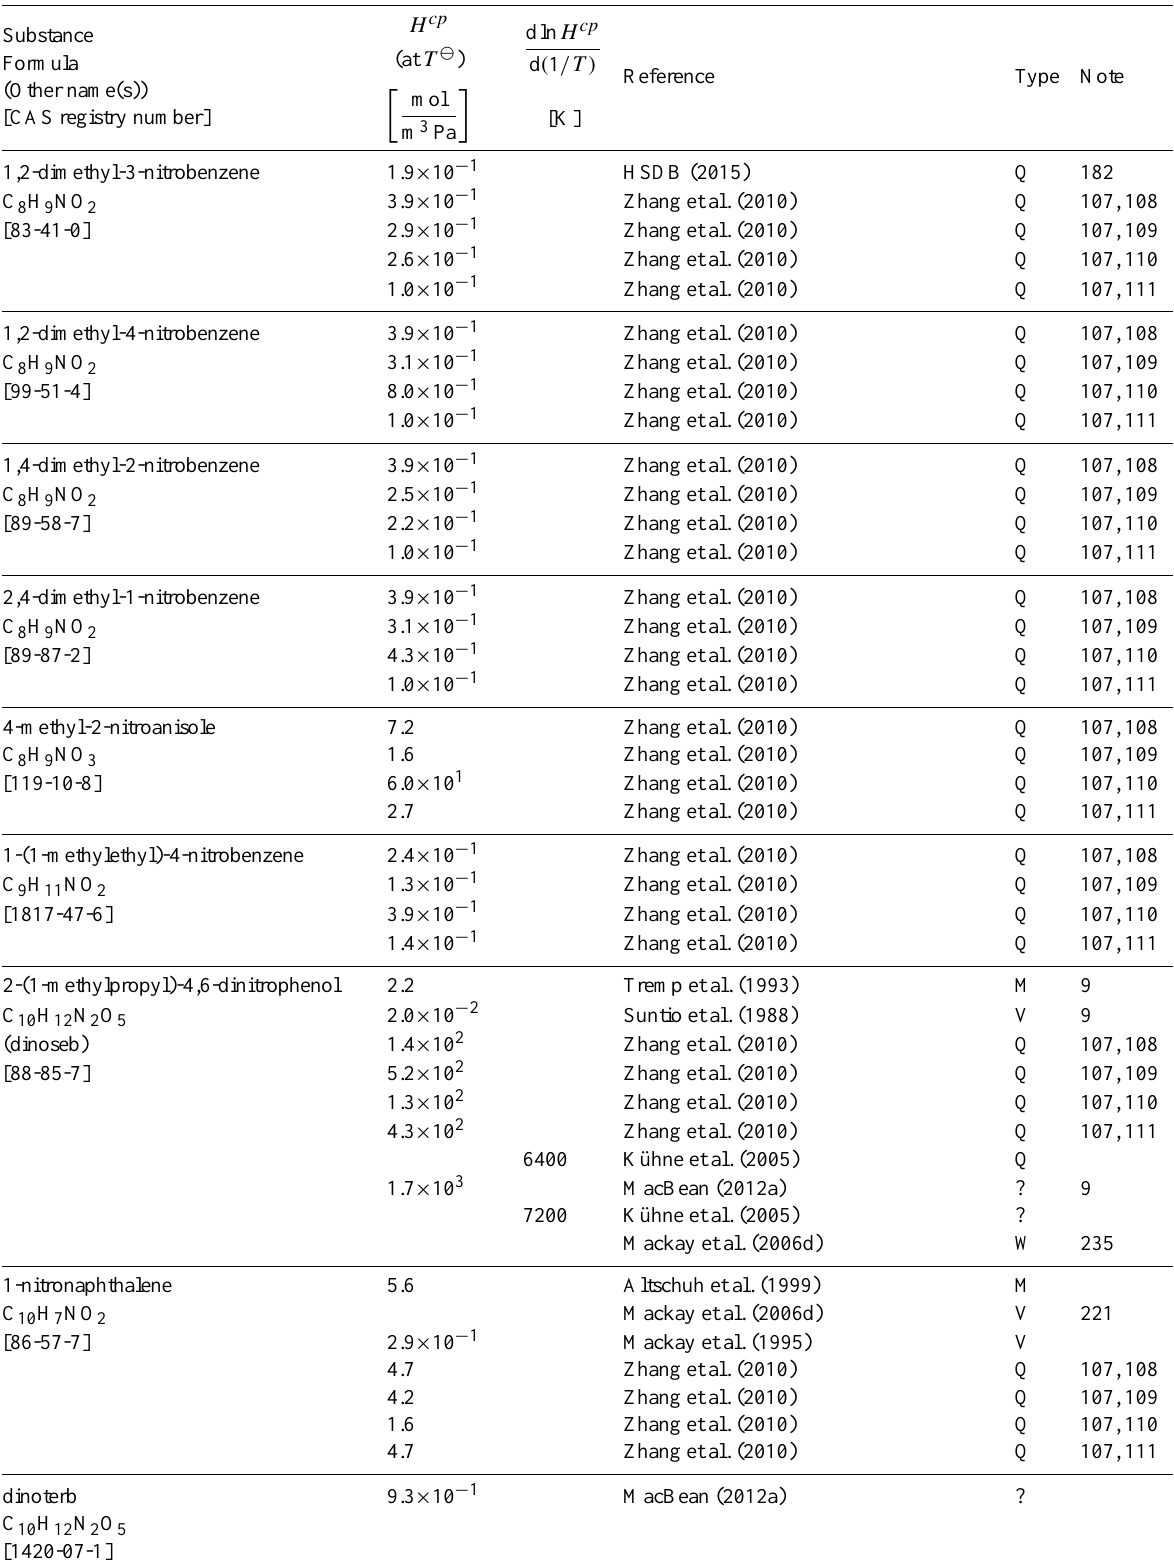
Table 6: Henry’s law constants for water as solvent